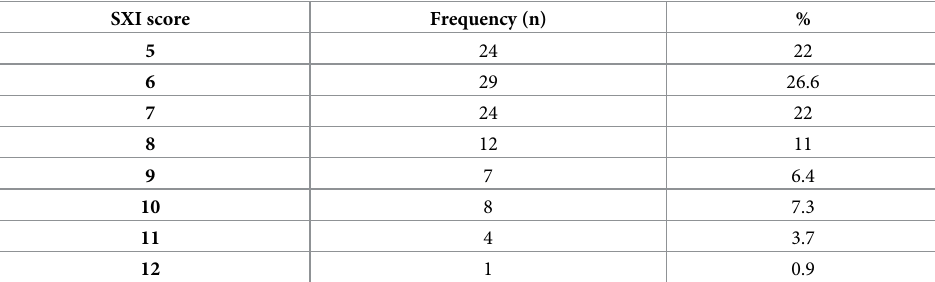
Table 2. Overall SXI score and participant frequency